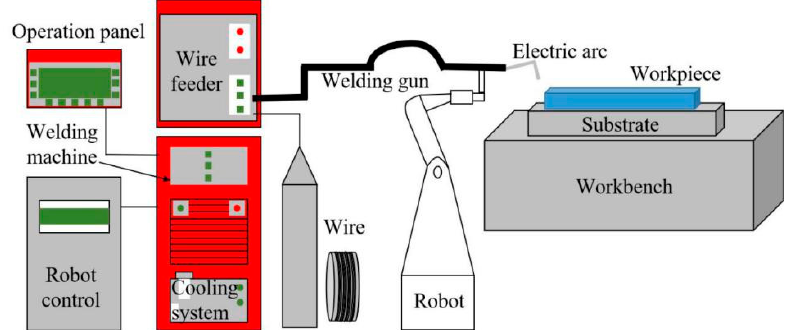
Figure 1. The sketch map of the WAAM-CMT equipment.